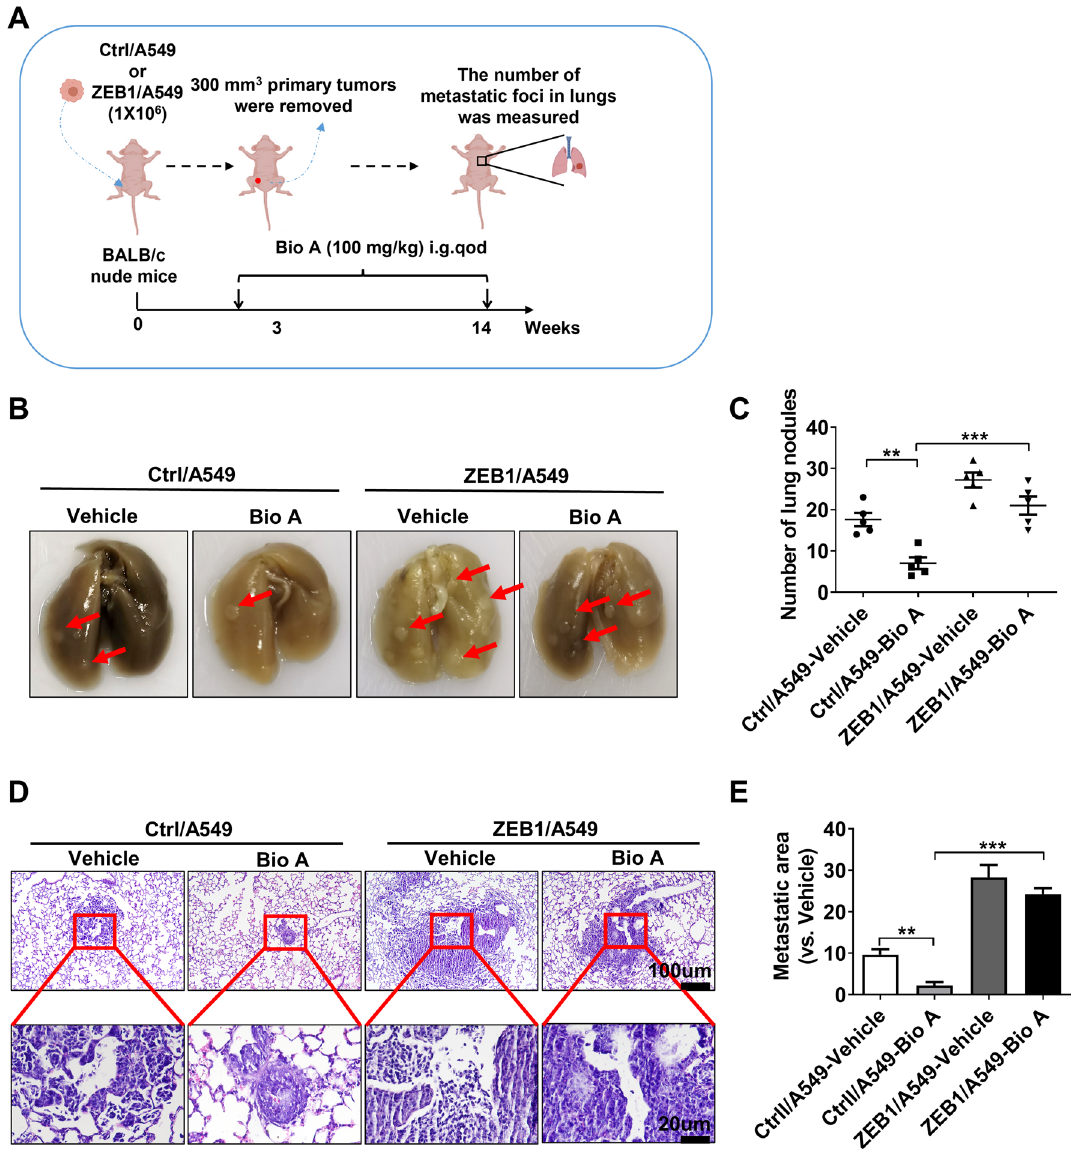
Fig. 5 Bio A inhibits lung adenocarcinoma metastasis in a ZEB1-dependent manner in vivo. A Experimental design of metastatic tumor xen- ograft in nude mice by treatment with Biochanin A. Representative images ( B ) and quantification ( C ) of the metastatic lung nodules from mice that were injected with ZEB1-expressing A549 cells by treatment with Biochanin A. ** P < 0.01, *** P < 0.001 vs. the respective control by an unpaired Student’s t -test. Representative images ( D ) and quantification ( E ) of the metastatic area from mice that were injected with ZEB1-expressing A549 cells by treatment with Biochanin A. ** P < 0.01, *** P < 0.001 vs. the respective control by an unpaired Student’s t